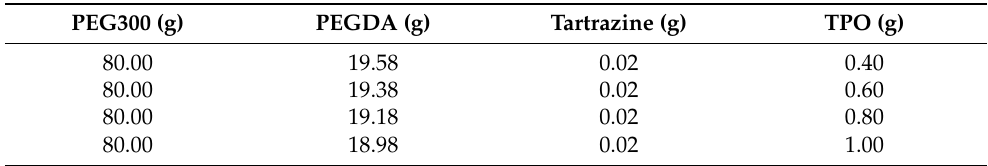
Table 2. The printing formulations with different ratios of photoinitiator (TPO).